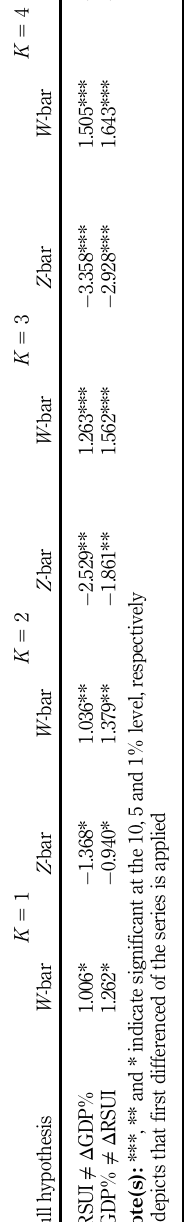
Table 5. Findings of heterogeneous panel causality